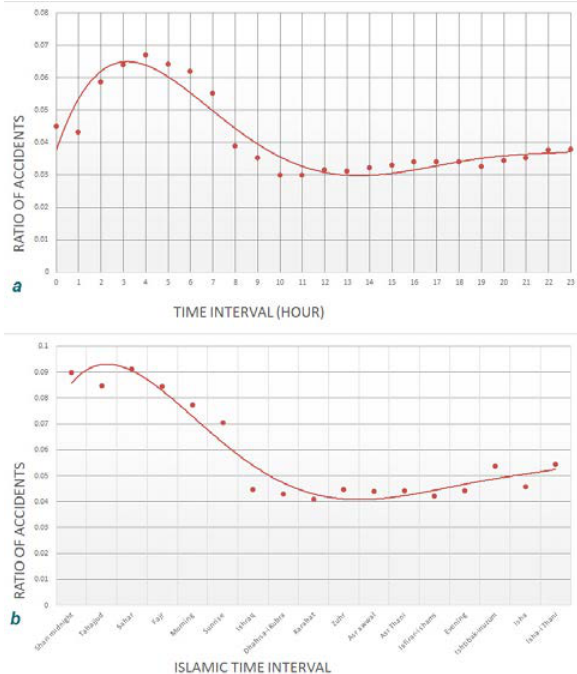
Figure 6. The percentage of accidents normalized with the traffic volume, (a) local time; (b) Islamic